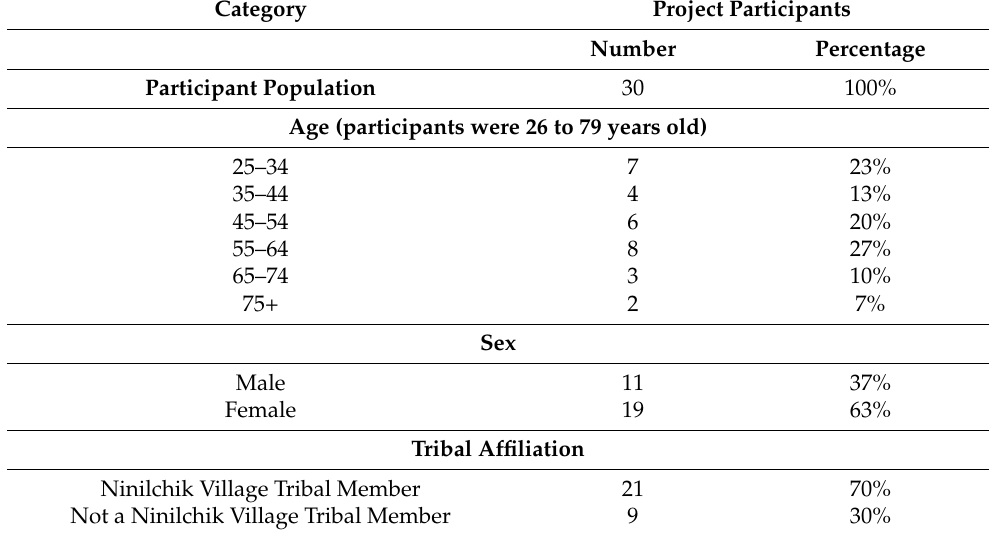
Table 1. Demographics of